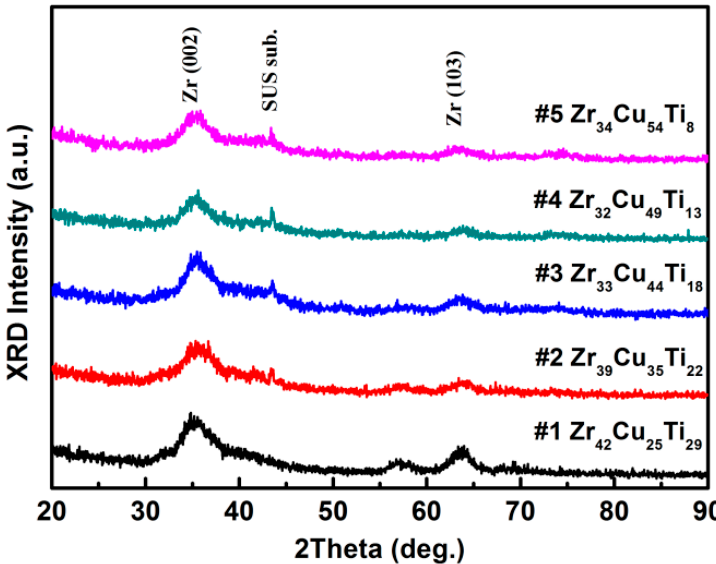
Figure 3. X-ray diffraction patterns of Zr-Cu-Ti coatings of various compositions.